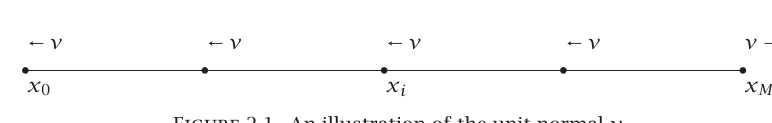
Figure 2.1 . An illustration of the unit normal ν